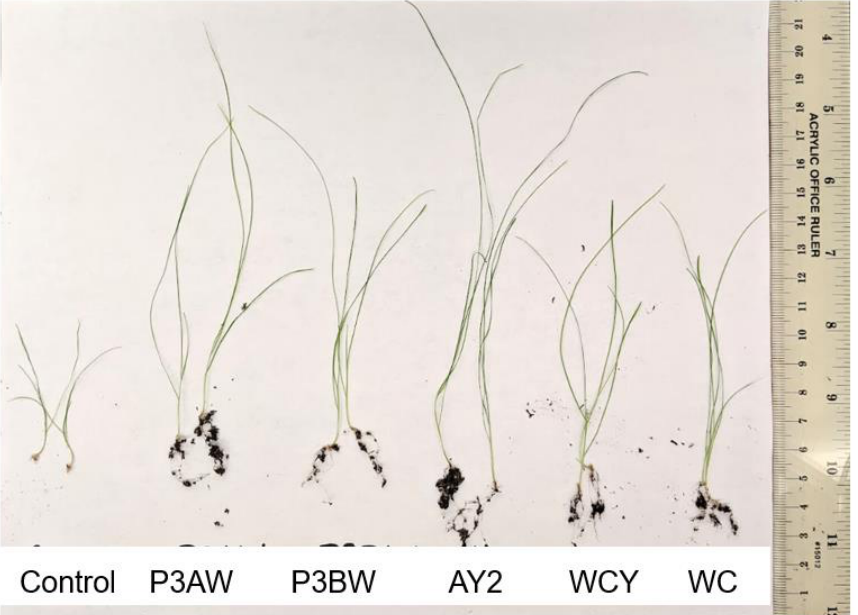
Figure 2. Visual comparison of Kentucky bluegrass seedlings inoculated with individual Pseudomonas sp. strains. Total number of seedlings germinated = 25, 25, 22, 23, 20, and 23, from left to right.